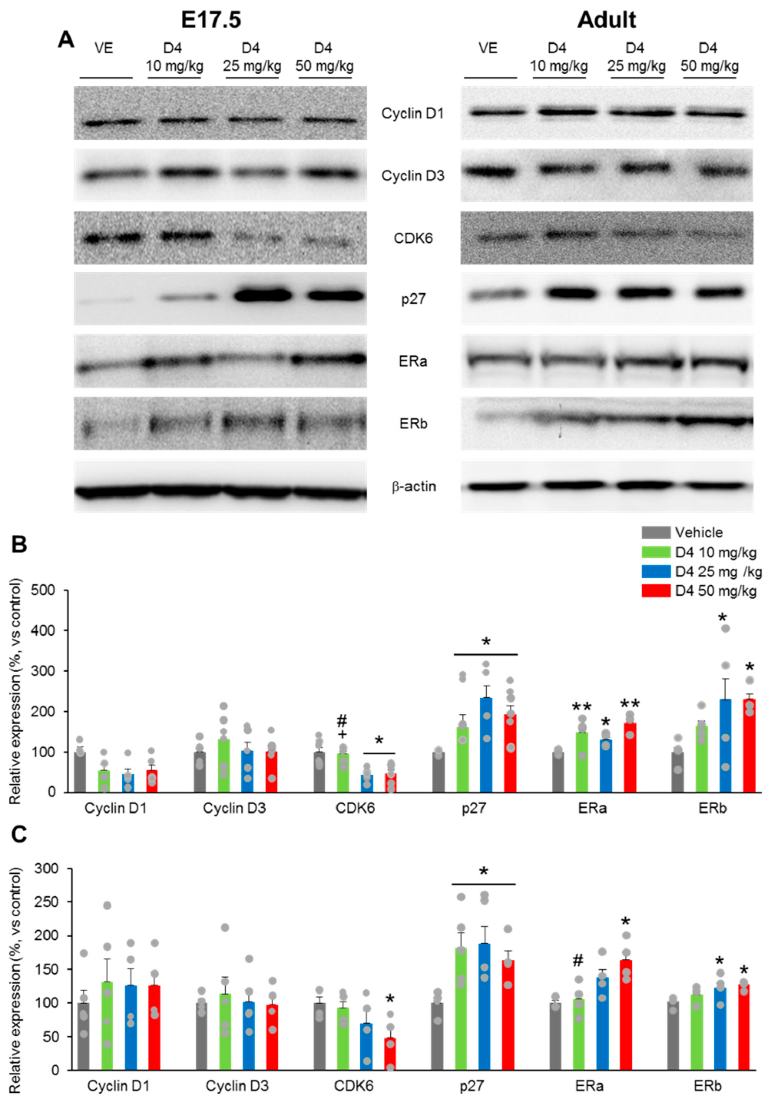
Figure 6. Prenatal D4 regulated cell cycle regulatory protein and estrogen receptor expression in neural progenitor cells. ( A ) Cell cycle regulatory protein content were analyzed by using Western blotting ( β -actin as loading control). ( B , C ) Quantification of ( A ). ( B ) At E17.5, D4 25 mg/kg and 50 mg/kg groups showed significant decreases in CDK6 compared to both vehicle and D4 50 mg/kg groups (F 3,22 = 8.886, p = 0.0007). Moreover, compared to vehicle group, D4-treated groups exhibited increases in p27 (F 3,22 = 3.374, p = 0.0465). n = 5–7 per group. ( C ) At adult stage, D4 50 mg/kg groups showed decreased in CDK6 (F 3,20 = 3.318, p = 0.0418). p27 was markedly higher in the D4-treated groups (F 3,20 = 11.39, p = 0.0002). D4-treated groups showed increases in ERa at both E17.5 (F 3,27 = 9.612, p = 0.0002) and adult stage (F 3,22 = 5.194, p = 0.0177). However, compared to vehicle groups, D4 25 mg/kg and 50 mg/kg group exhibited increases in ERb E17.5; F 3,29 = 4.406, p = 0.0124; adult; F 3,27 = 5.218, p = 0.0065). n = 5 per group. Data represent mean ± SEM. Statistical significance was determined by one-way ANOVA with Bonferroni correction. * p < 0.05 vs. vehicle, ** p < 0.01 vs. vehicle, # p < 0.05 D4 10 mg/kg vs. D4 50 mg/kg, + p < 0.05 D4 25 mg/kg vs. D4 50